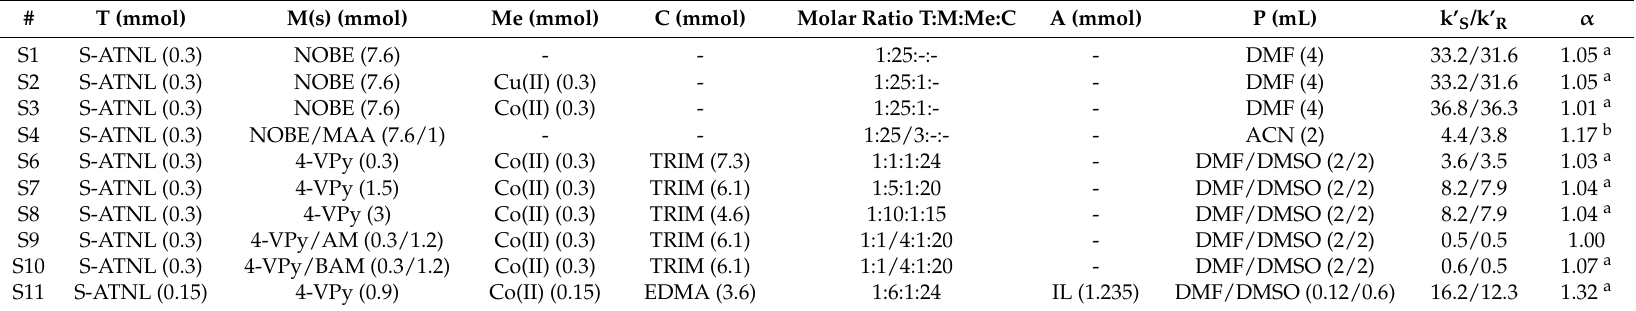
Table 1. Chromatographic retention (k’) and enantioselectivity ( α ) of various MIP-CSPs tested in slurry packed columns (S1–11).